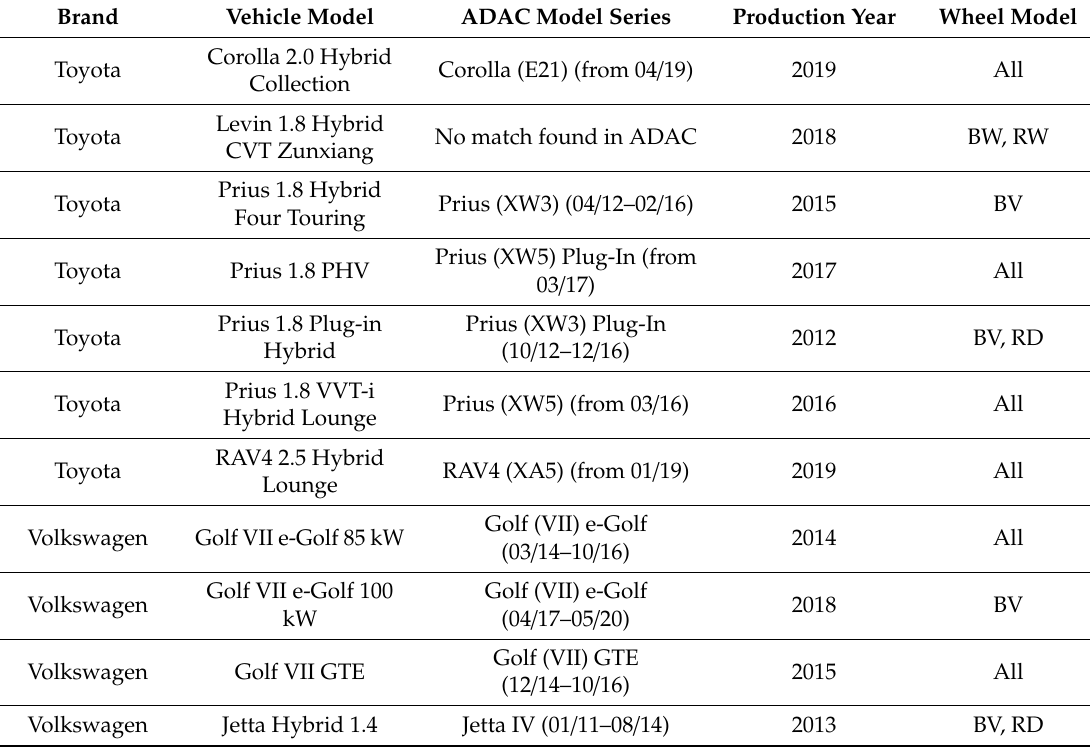
Table A3. Database overview, part